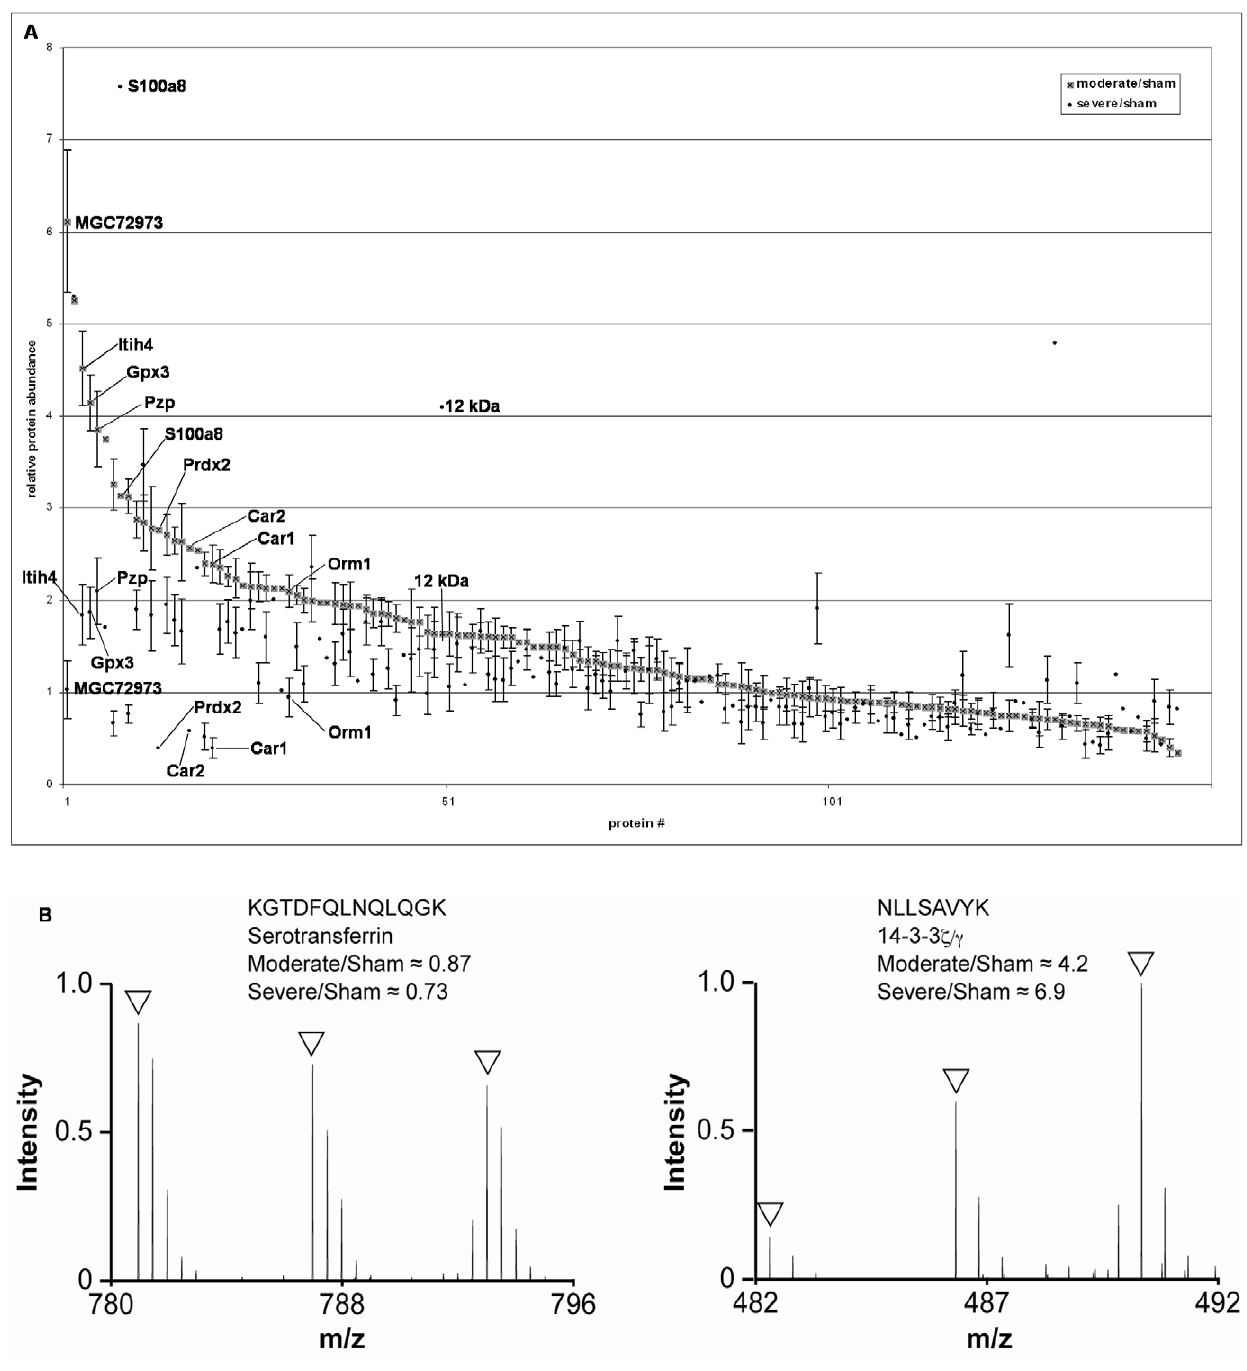
Figure 3. Quantitative proteomic analysis of CSF from injured animals. (a) Relative protein abundances for all proteins detected in rat CSF 24 h after sham, moderate or severe SCI. Labeled data points represent potential biomarkers of SCI severity (Tables 3 and 4). Error bars represent standard error of the mean (SEM). (b) Representative examples of MS spectra from the indicated peptides. Open arrowheads point to the monoisotopic peaks from light (sham), medium (moderate) and heavy (severe) conditions.